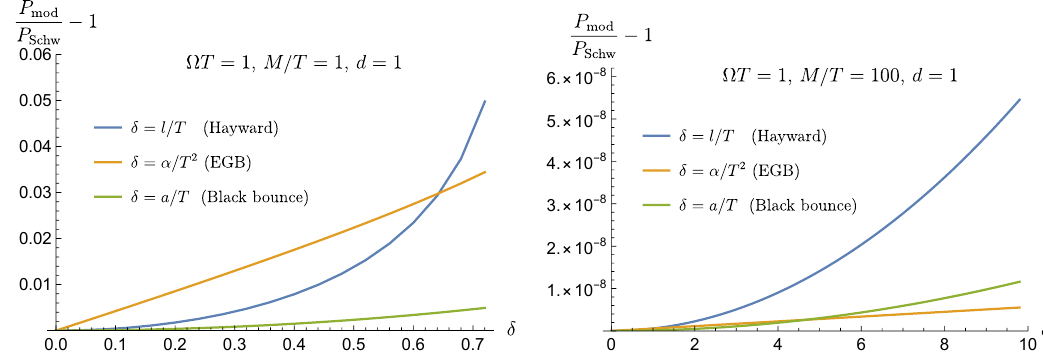
Figure 2 . The probability differences, computed as ratio R = P mod /P Schw − 1 as a function of (dimensionless) deformation parameter δ as defined in eq. (4.11). We set Ω T = 1 and the detector is at (dimensionless) proper distance d = 1 from the horizon. (a) Small mass regime M/T = 1 . (b) Large mass regime M/T = 100 . In all cases the deformation increases the detector responses, but they grow with different scaling